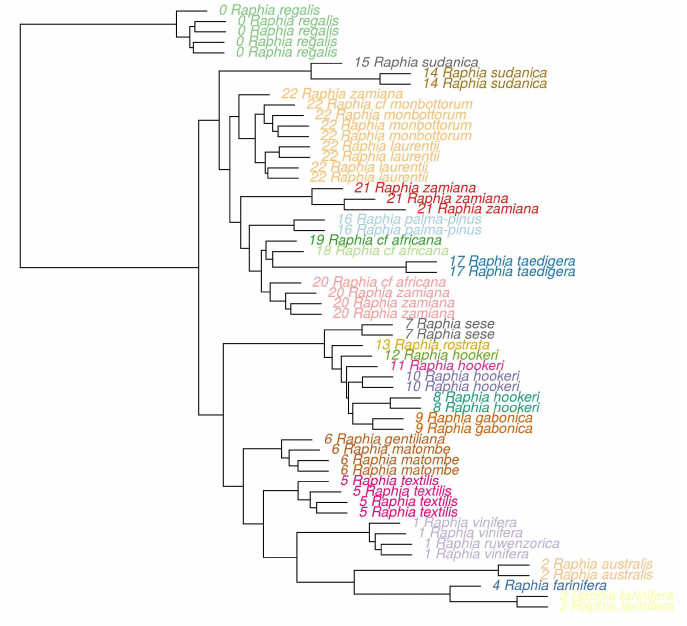
Figure A2. ASTRAL tree of Raphia including inferred branch lengths (except terminal branch lengths) and tip labels colored with species delimitation as inferred with SODA ( α =